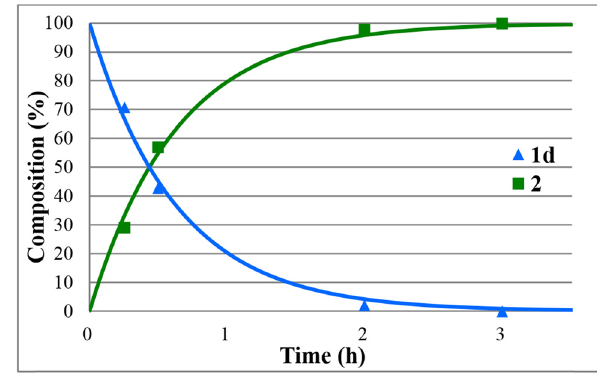
Figure 4: Concentration pro fi le for the components ( 1d and 2 ) during the hydrolysis of isopropyl diphenylphosphinate ( 1d ) under optimum conditions. The R 2 measure of goodness of fi t is 0.993.